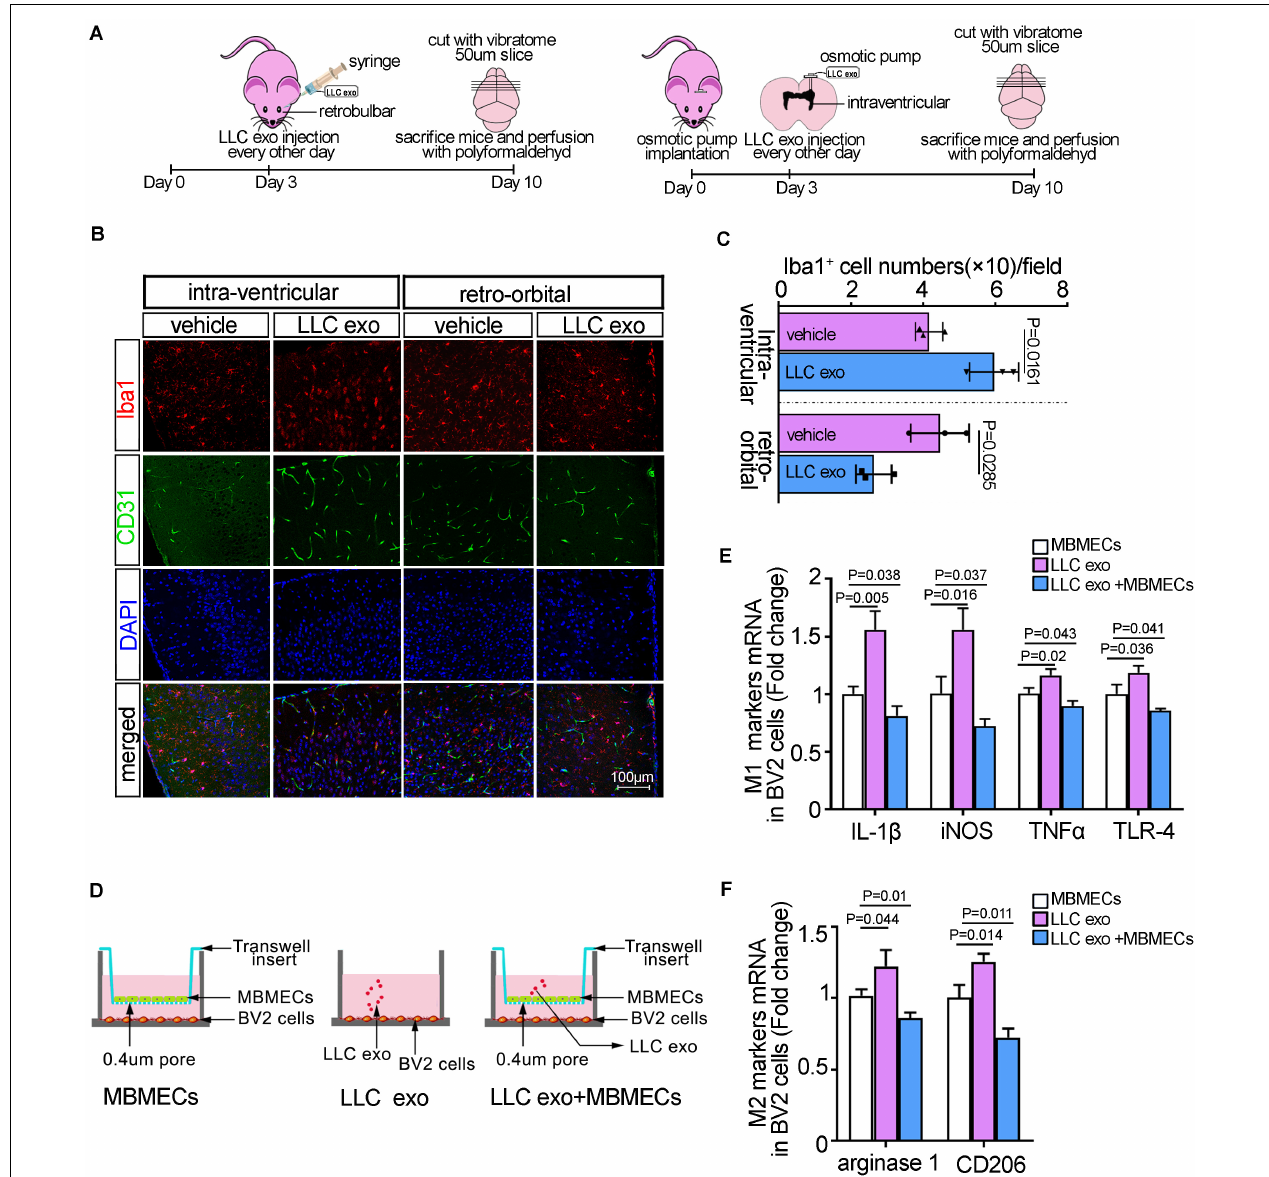
FIGURE 1 | The uptake of lung cancer cells-derived exosomes by brain endothelia cells offered an inhibitor signal to microglia. (A) Schematic illustration of the methods of LLC exosomes administration to C57 mice. (B) Representative immunofluorescence staining for Iba1 and CD31 from cerebral cortex regions of the injected side after retro-orbital injection and intra-ventricular injection, respectively. Scale bar, 100 µ m. (C) Quantitative analysis for the numbers of Iba-1-positive microglia cells. The PBS alone was as the vehicle. The histograms represented the average numbers of Iba-1-positive microglia cells from the total 6 random visual fields in three independent experiments. (D) The schemes of the in vitro cellular co-cultured experiment and the methods of LLC cell-derived exosomes treatments. (E) The qRT-PCR analysis of M1 markers (IL-1 β , iNOS, TNF α , and TLR-4) in BV2 cells in the presence or absence of LLC cells-derived exosomes in cellular co-cultured system. The results were presented as mean ± SD of three independent experiments. (F) The qRT-PCR analysis of M2 markers (arginase-1 and CD206) in BV2 cells in the presence or absence of LLC cells-derived exosomes in cellular co-cultured system. The results were presented as mean ± SD of three independent